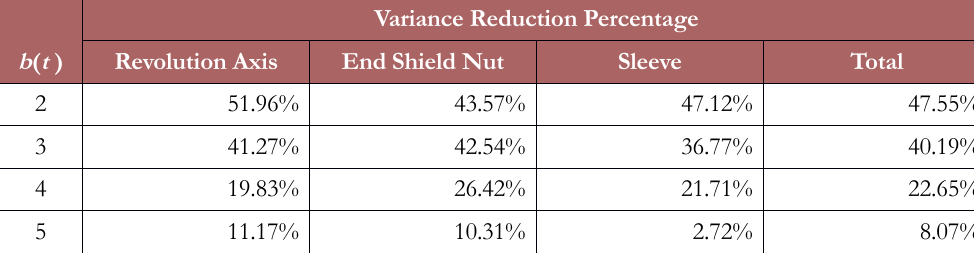
Table 26. Effects of Interruption time to the variance reduction